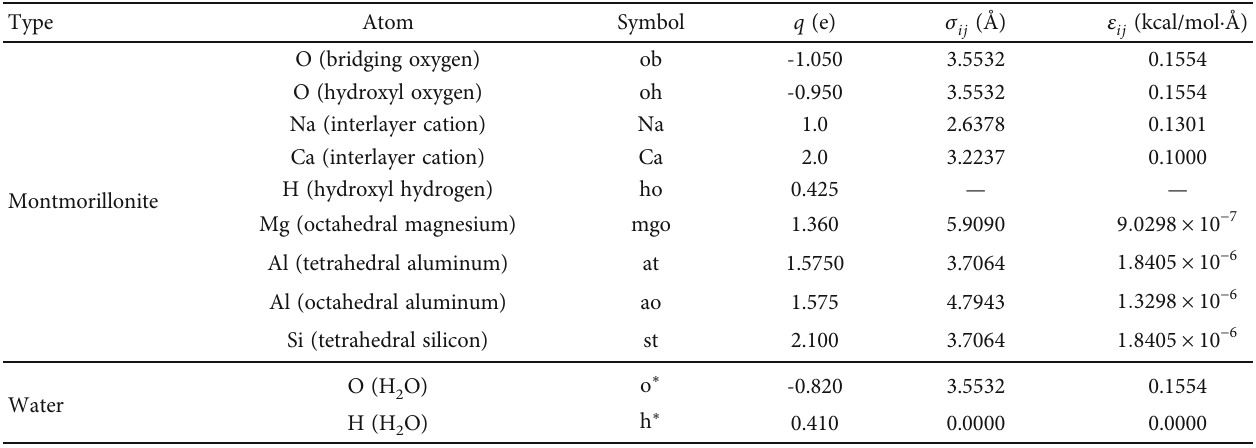
Table 4: Force fi eld and charges of montmorillonite and water.